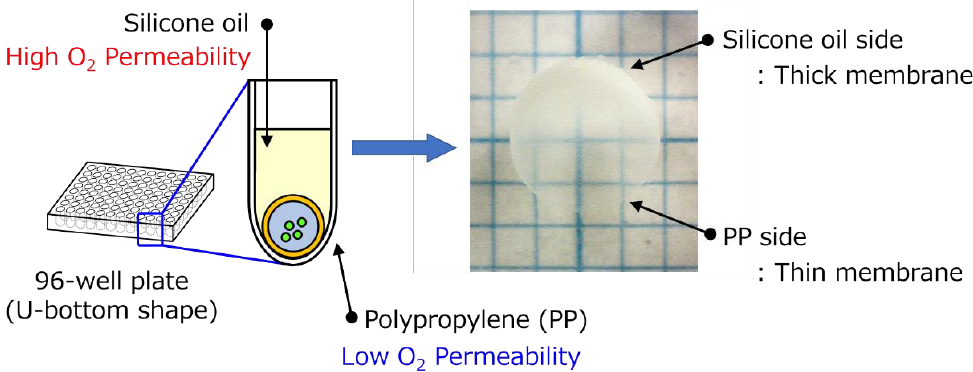
Figure 4. Non-uniformity of the gelatinous membrane thickness of the HSBC gel produced using method A.